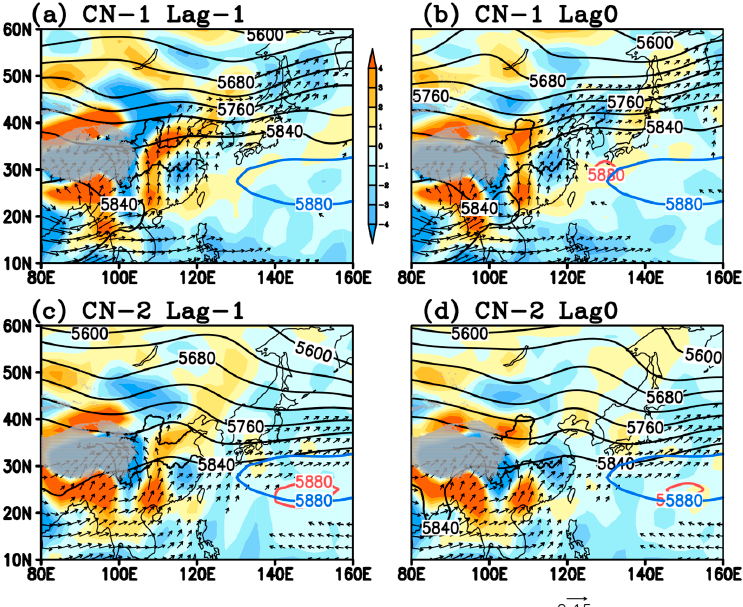
Figure 9. Composites of the 850 hPa water vapor transportation (vector, units: m·kg·s − 1 ·kg − 1 ) and divergence (colored shading, same for all subplots, units: kg·s − 1 ·kg − 1 ) and of 500 hPa geopotential height (black contour, units: gpm) at Lag − 1 day ( a , c ) and Lag 0 day ( b , d ) for the normal precipitation events in CN-1 ( a , b ) and CN-2 ( c , d ). The 5880 gpm contour and the climatologic July and August mean 5880 gpm contours are highlighted as a thick red line and thick blue line, respectively. The gray shaded areas indicate elevations > 3200 m.